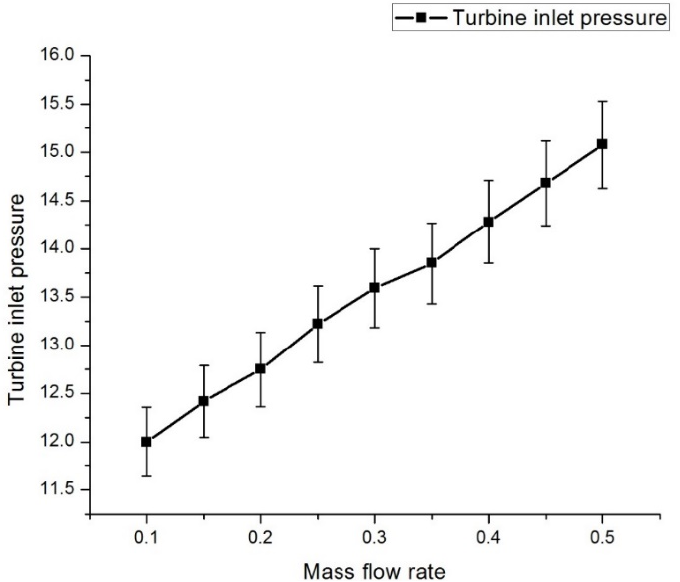
Figure 6. Variation of turbine inlet pressure with mass flow rate of the working fluid.